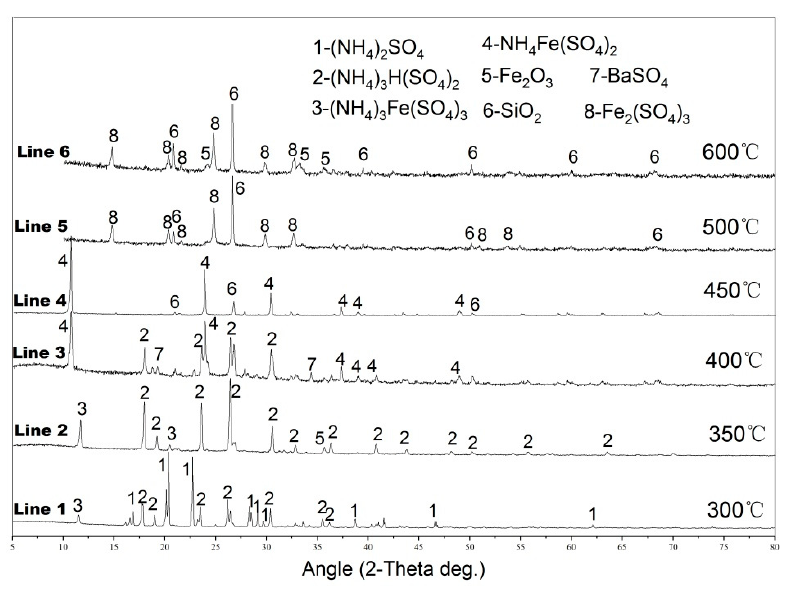
Figure 2. X-ray patterns of the roasting products at different temperatures.